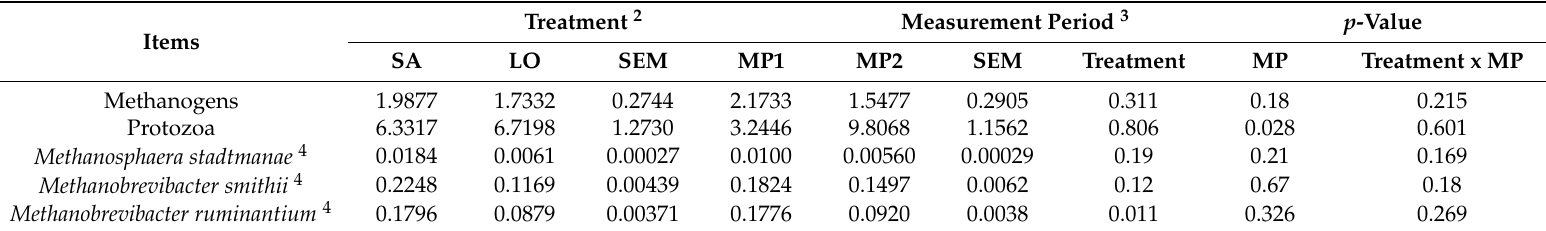
Table 7. E ff ect of linseed oil supplementation on ruminal Protozoa and Methanogen populations 1 .